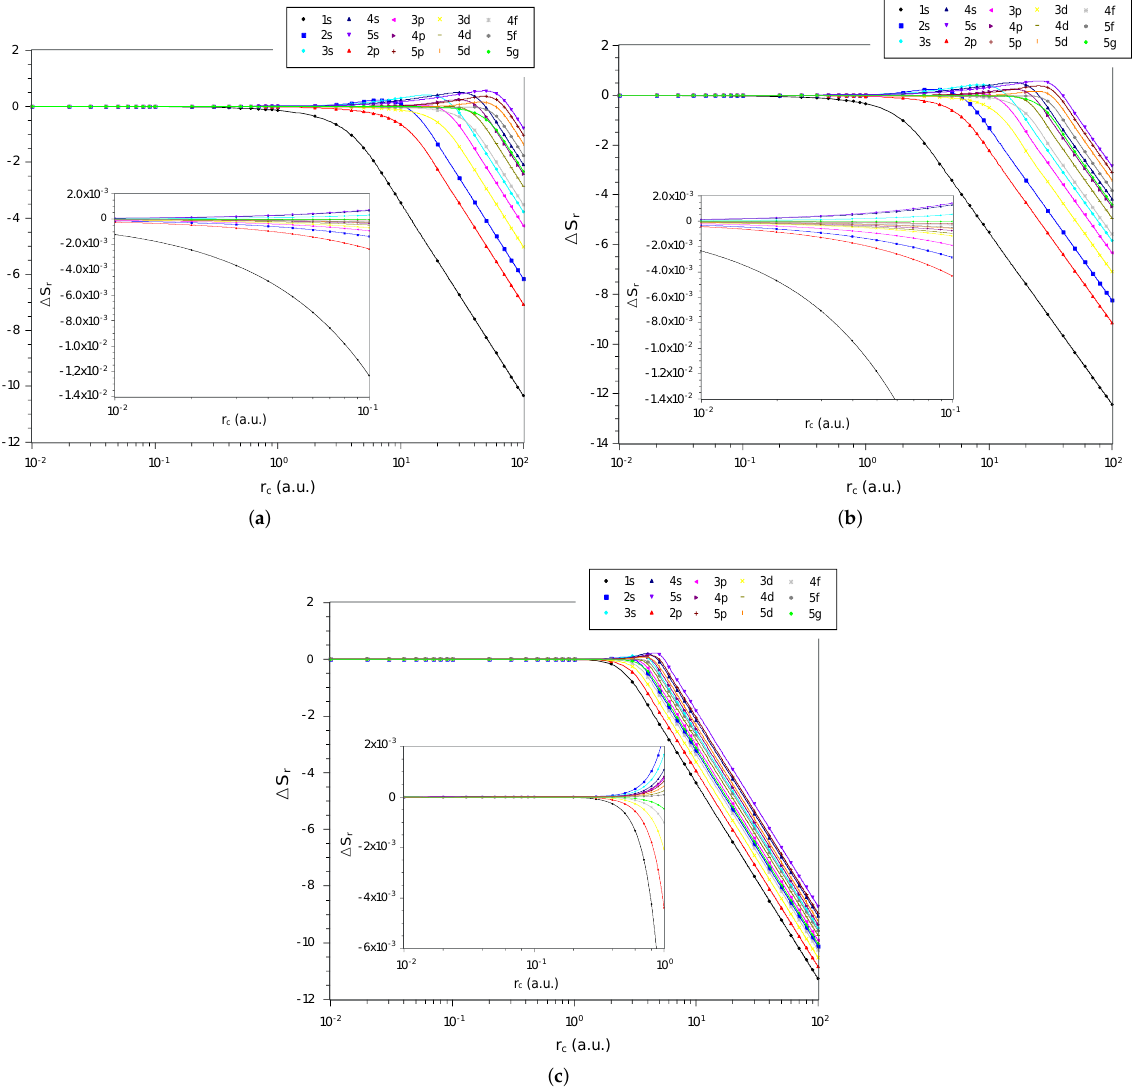
Figure 1. Values of ∆ S r in different quantum states as a function of r c on a logarithmic scale for the ( a ) hydrogen confined, ( b ) ion-sphere, and ( c ) confined harmonic oscillator. In the case of moment space entropy, the comparison between states and systems is quite similar to the one made for position space entropy. The sign change behavior of the entropy difference in some regions of r c is also noticed for the hydrogen confined and the ion-sphere systems. In particular, the entropy difference of some states seems to oscillate more prominently when compared to the position space ones. The states that present ∆ S p < 0 are 2 s , 3 s , 4 s , 5 s , 4 p , and 5 p and 5 d , for the confined hydrogen and the ion-sphere, respectively; and, in the case of the harmonic oscillator, there are no regions with sign